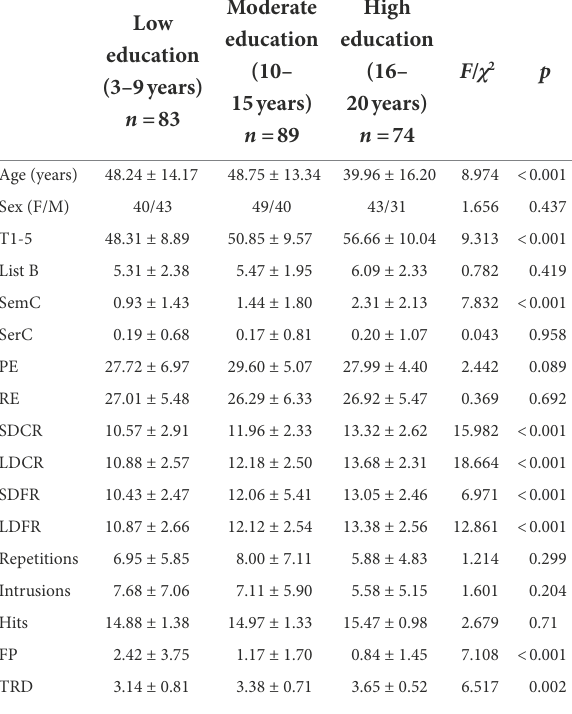
TABLE 3 CVLT-II factors in different education